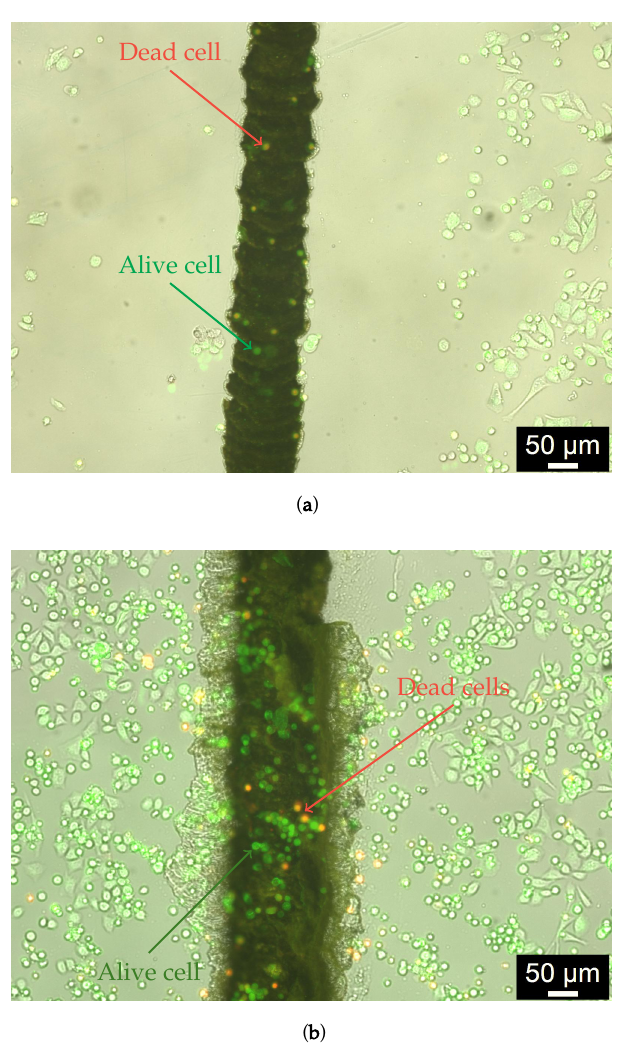
Figure 7. Investigation of biocompatibility of Cu ( a ) and Cu–Ru ( b ) electrodes. The dead and alive cells are shown in yellow and green, respectively (the examples of the dead and alive cells are shown by arrows). Cu–Ru electrode exhibits much better biocompatibility in comparison with pure Cu electrode (90 vs. 30% of alive cells).